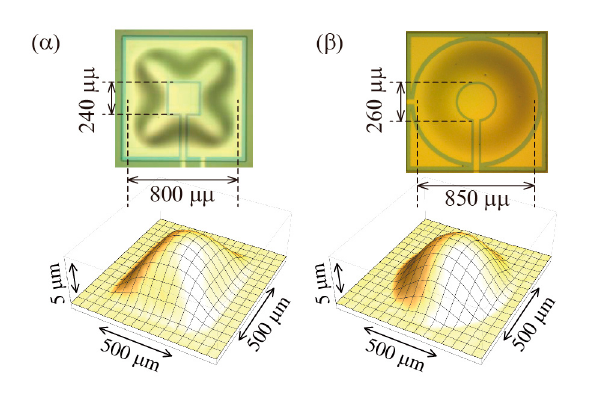
Figure 2. Photographs and 3D profiles of ( a ) square, and ( b ) circular